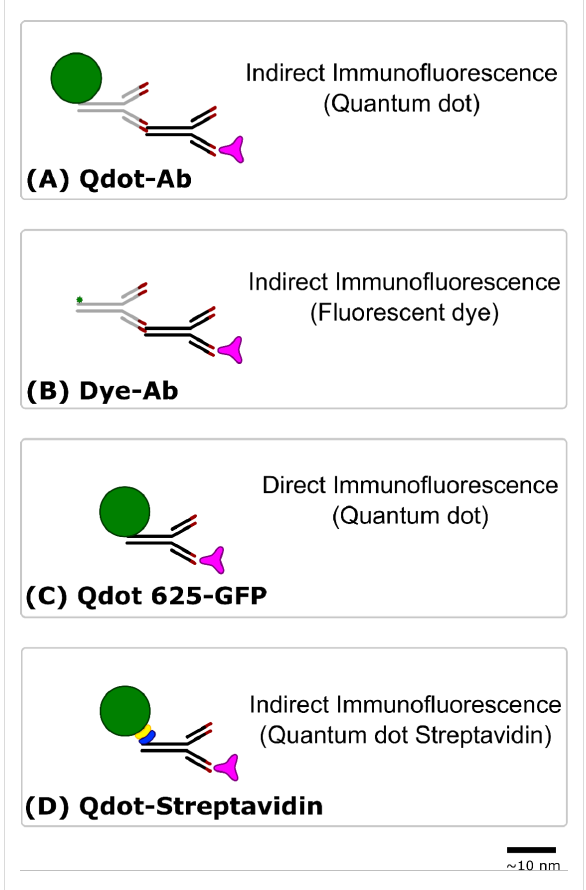
Figure 1: Strategies for immunofluorescence labelling. A fluorescent label (green) is conjugated to a secondary antibody (grey) or directly to a primary antibody (black), containing antigen-binding sites (red), which recognises and binds to a specific antigen (pink). Immunofluo- rescence labelling was either indirect with a primary antibody and a Qdot 625/Qdot 525 (Qdot-Ab) (A) or fluorescent dye such as Alexa Fluor 488/Cyanine 3 (Dye-Ab) (B) conjugated to a secondary antibody, or direct with an anti-GFP primary antibody conjugated to Qdot 625 (Qdot 625-GFP) (C). An alternative Qdot 625 was tried for indirect immunofluorescence labelling using a Qdot 625 streptavidin (yellow) conjugate (Qdot-Streptavidin) and biotinylated (blue) primary antibody (D). Scale bar is 10